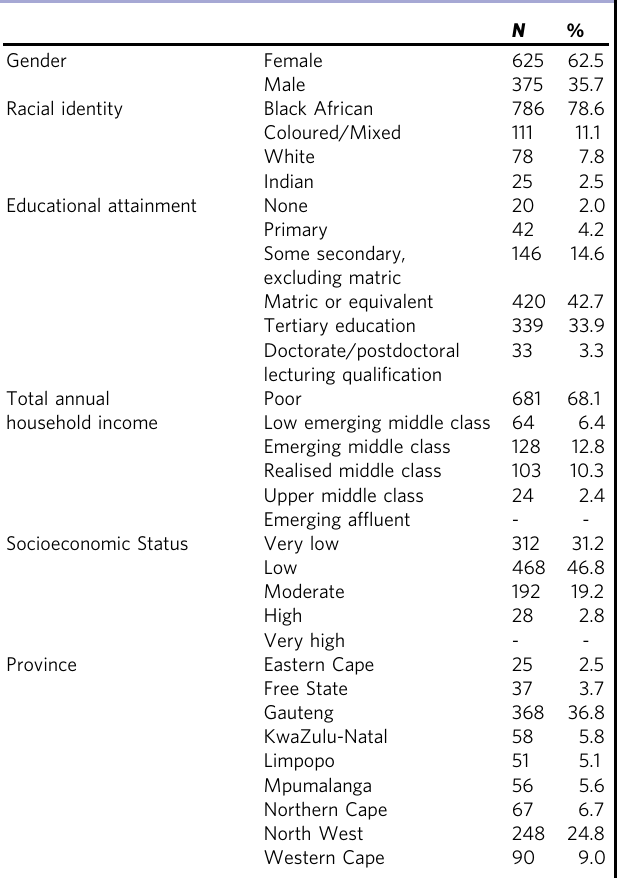
Table 1 Sample characteristics ( N =